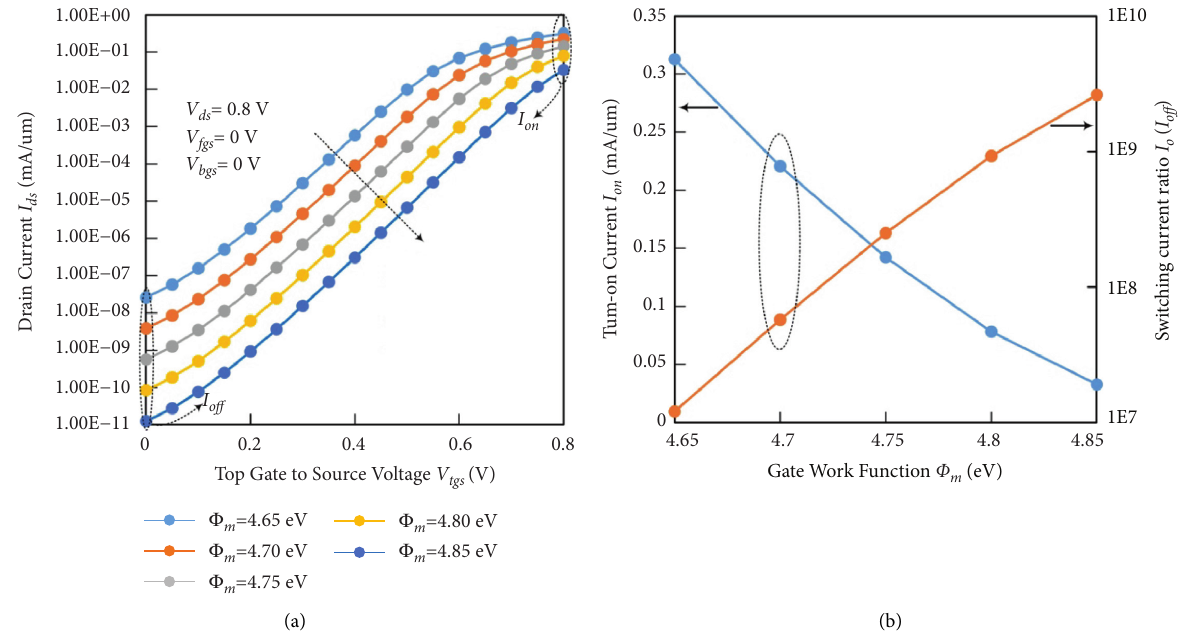
Figure 9: (a) The drain current I ds and (b) turn-on current I on and switching current ratio I on / I off with different work functions when both V V fgs and bgs are set as 0V.